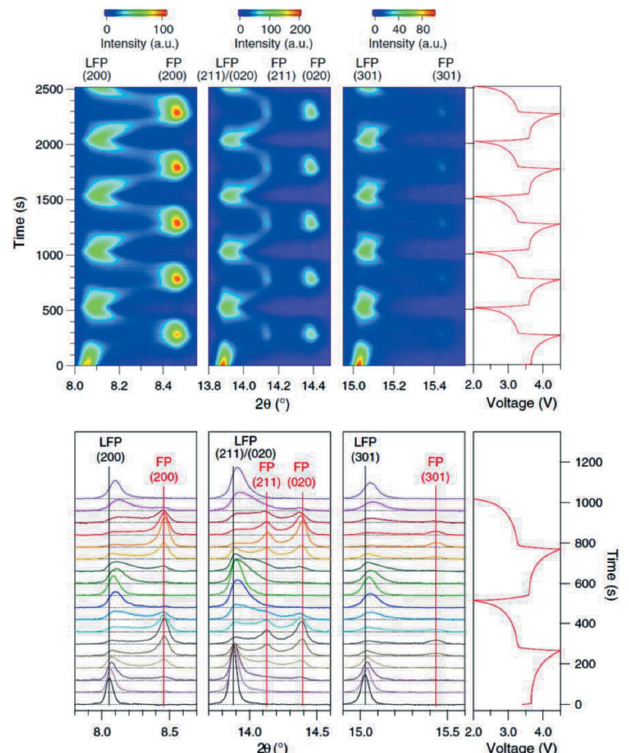
Figure 7 (Top) Operando synchrotron powder diffraction data for an LiFePO 4 ||Li cell cycled at C /10 with data collected every 4 s for the first five cycles and (bottom) the derived phase evolution. LFP is LiFePO 4 and FePO 4 is denoted FP. Reprinted with permission from Liu et al. (2014). Copyright (2014)